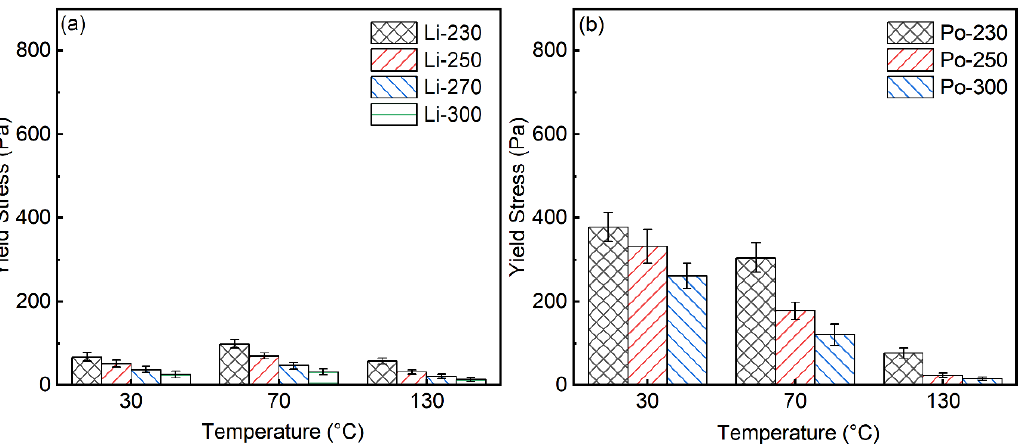
Figure 10. Yield stress τ y of greases under steady-state test conditions: ( a ) lithium grease, ( b ) poly- urea grease.